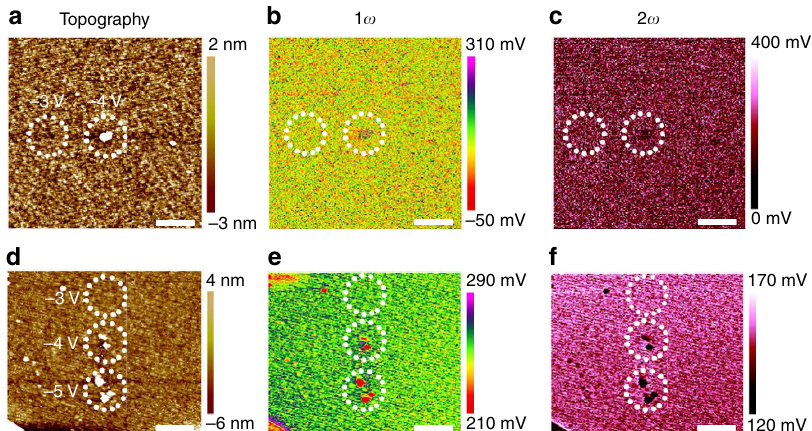
Figure 3 | Electrostatic force microscopy characterization after negative voltage sweeps. ( a – c ) Topographic ( a ), 1 o ( b ) and 2 o ( c ) measurements on the HfO 2 /TiN sample undergoing negative voltage sweepings in preceding C-AFM measurements. The voltage amplitudes were –3 and –4V at different locations. Scale bar, 1 m m. ( d – f ) Topographic ( d ), 1 o ( e ) and 2 o ( f ) measurements on the HfO 2 /TiN sample undergoing negative voltage sweepings. The voltage amplitudes were –3, –4 and –5Vat different locations. Scale bar, 1 m m. The regions of interest are marked by circles. These repeated studies showed highly consistent results, where no charge accumulations were observed in case of negative voltage sweeps until structural deformations took